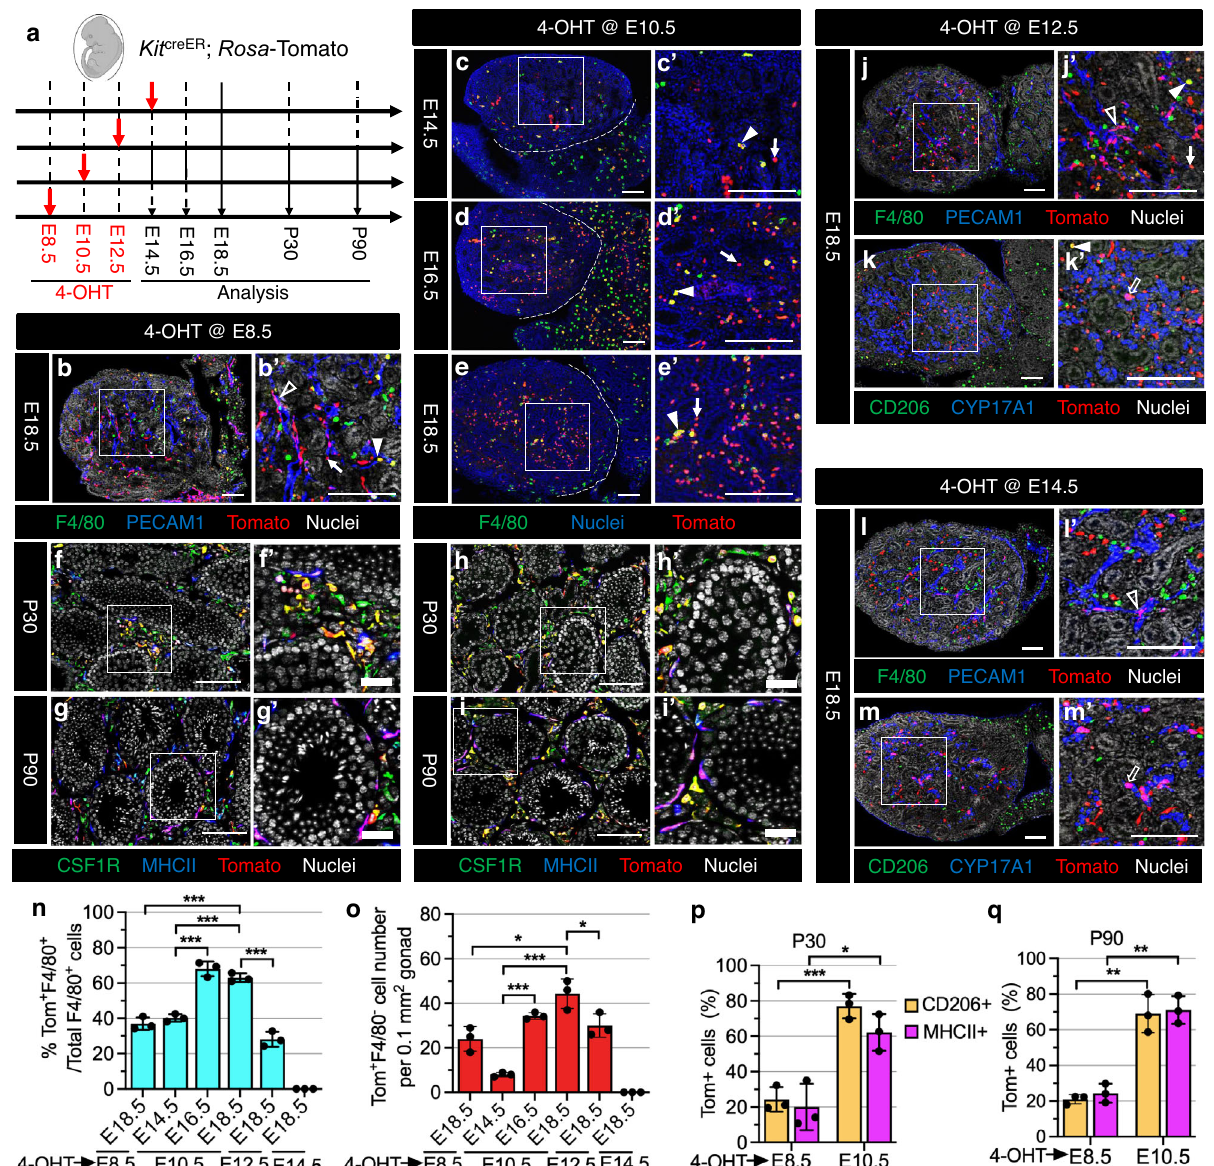
Fig. 2 | Contribution of AGM-derived HSCs to adult testicular macrophages occurs within a speci fi c recruitment window during fetal development. a Strategy for 4-OHT-induced lineage-tracing and harvesting of testes from Kit creER ; Rosa -Tomato embryos and juvenile/adult mice. Embryo image was created with BioRender.com software (BioRender.com). b – m Representative images ( n =3 independent gonads) of testes at various stages from Kit creER ; Rosa -Tomato mice exposedto4-OHTatE8.5( b , f , g ),E10.5( c – e , h , i ),E12.5( j , k ),orE14.5( l , m ).Dashed lines indicate gonad – mesonephros boundary. Black arrowheads denote Tomato- expressing PECAM1 + endothelial cells, white arrowheads denote Tomato- expressing F4/80 + macrophages, black arrows denote Tomato-expressing